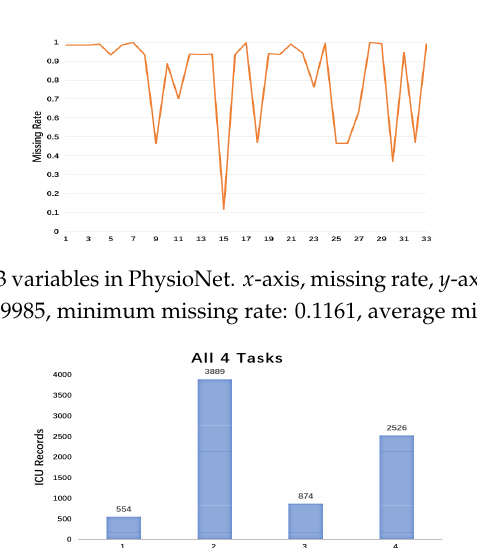
Figure 6. The label distribution in all four tasks. x -axis, label id in all four tasks, 1: in-hospital mortality, 2: length-of-stay less than 3 days, 3: whether the patient had a cardiac condition, 4: whether the patient was recovering from surgery; y -axis, the number of ICU records with positive labels.